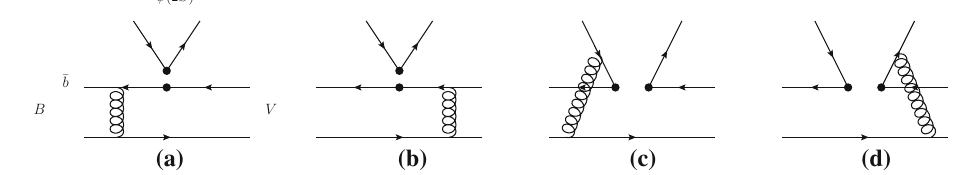
Fig. 1 The typical leading-order Feynman diagrams for the decay B → ψ( 2 S ) V . a , b The factorizable diagrams, and c , d the non-factorizable